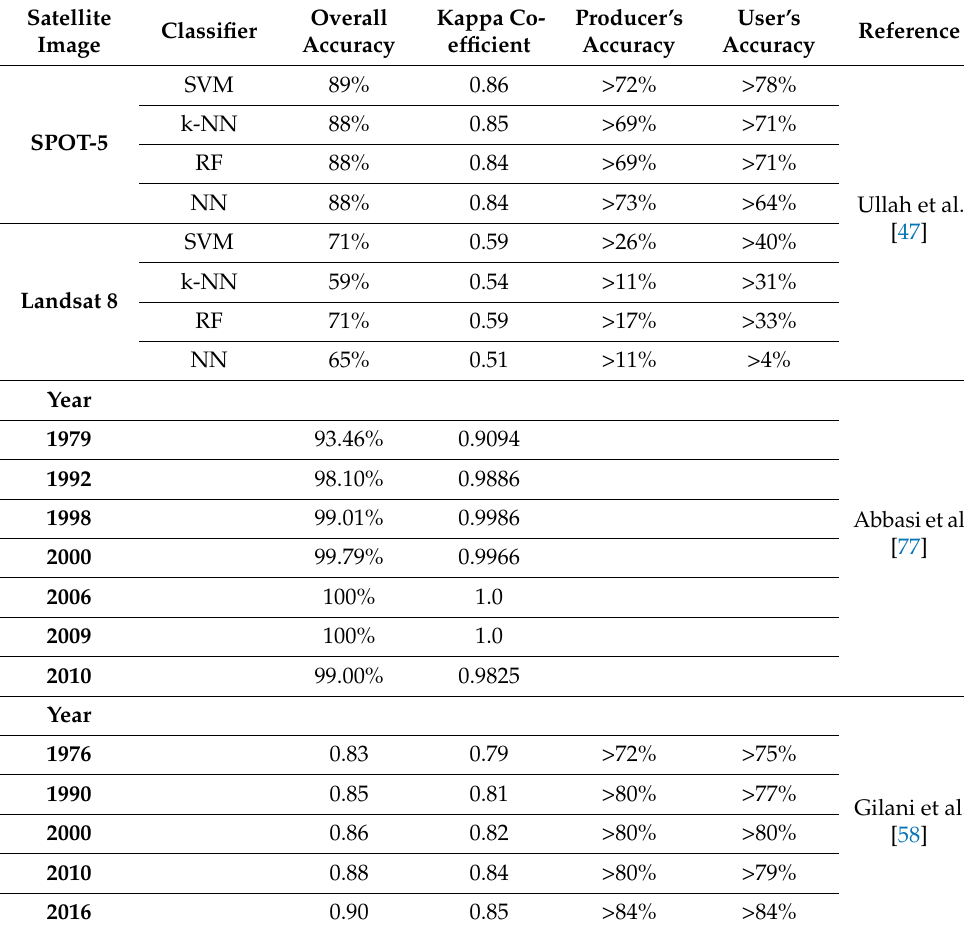
Table 2. Details of accuracies achieved by researchers for image classification of forests in